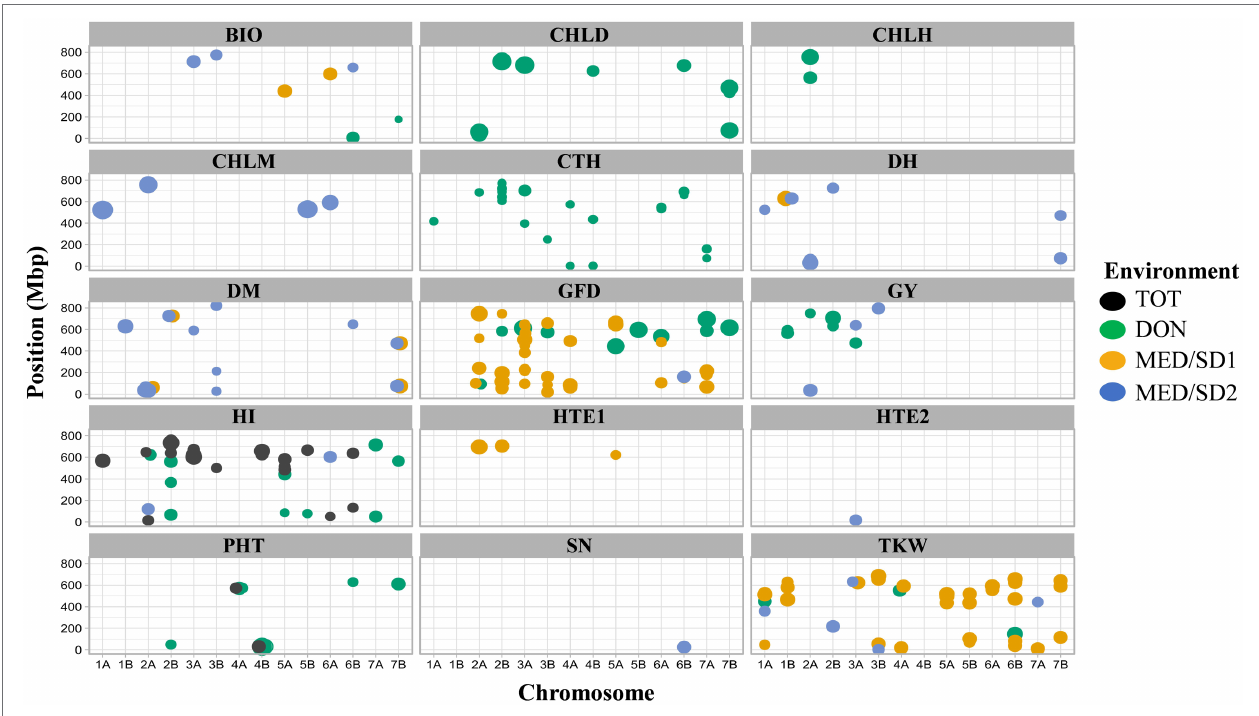
FIGURE 4 | Physical positions of markers associated with evaluated traits in the four environments; Tottori (TOT); Dongola (DON); Wad Medani first sowing date (MED/SD1); and Wad Medani second sowing date (MED/SD1). BIO, biomass; CHLD, chlorophyll degradation; CHLH, chlorophyll at heading; CHLM, chlorophyll at maturity; CTH, canopy temperature at heading; DH, days to heading; DM, days to maturity; GFD, grain filling duration; GY, grain yield; HI, harvest index; HTE1, heat tolerance efficiency evaluated in MED/SD1; HTE2, heat tolerance efficiency evaluated in MED/SD2; PHT, plant height; SN, seed number/spike; TKW, thousand kernel weight. Symbol size corresponds to the allelic effect of each